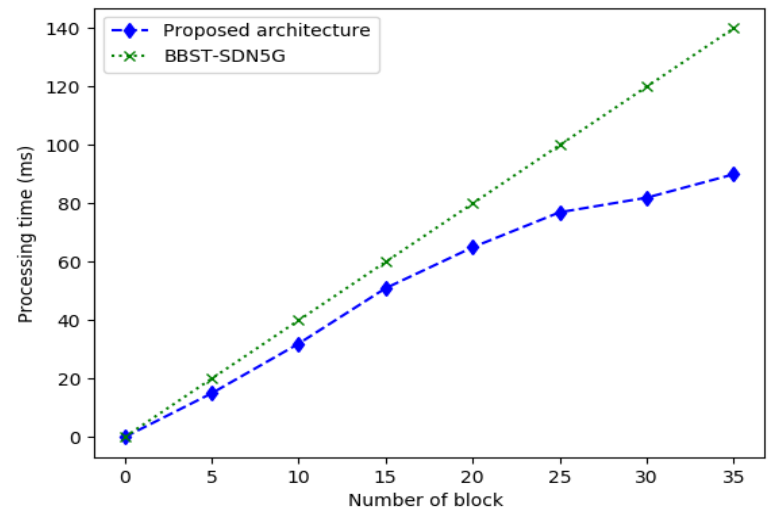
Figure 4. Impact of the number of blocks on process time